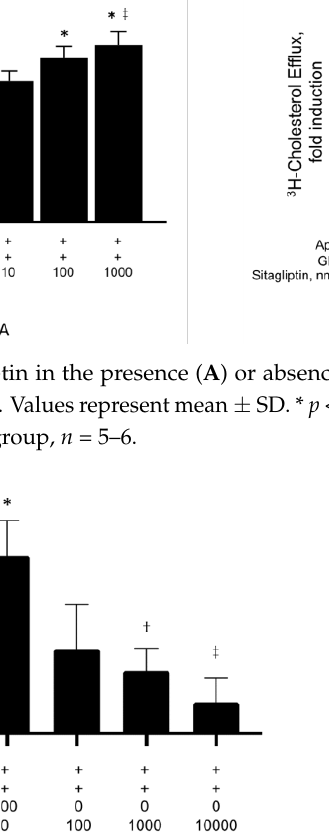
Figure 2. Effect of sitagliptin and vildagliptin in the presence of GLP-1 (10 nmol/L) on apoA1- mediated cholesterol efflux. Values represent mean ± SD. * p < 0.05 vs. apoA-I + GLP-1, † p < 0.05; ‡ p < 0.01 vs. sitagliptin (100 nmol/L). Each group, n = 4 – 8.